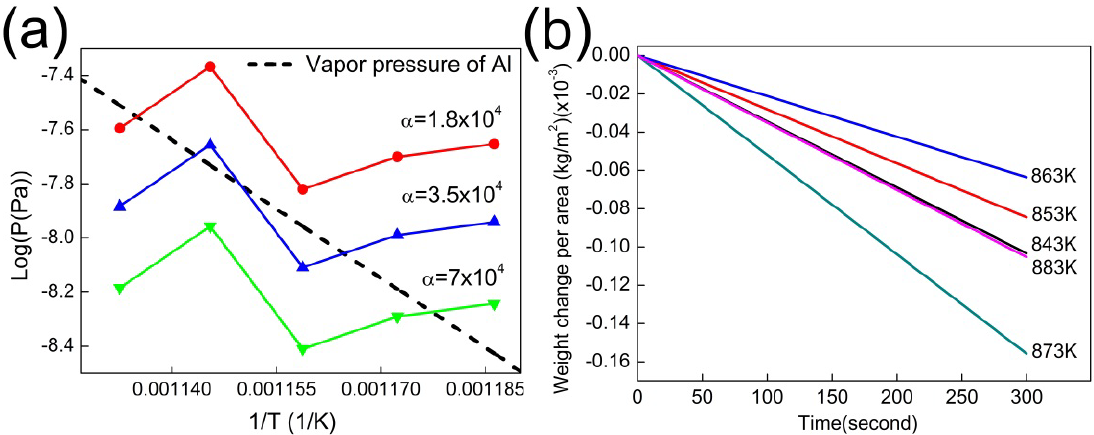
Figure 3. ( a ) The value of α was obtained by comparing the previously reported vapor pressure of Al (dotted line) to the vapor pressures of the Al foils calculated using Equation (1). For the calculation, the weight loss rates of the Al foils were measured at various temperatures as shown in ( b ) and the vapor pressures at these temperatures were calculated using Equation (1) with the three possible values of alpha, 1.8 × 10 4 (red line), 3.5 × 10 4 (blue line), and 7.0 × 10 4 (green line). The optimum value of α is approximately 3.5 × 10 4